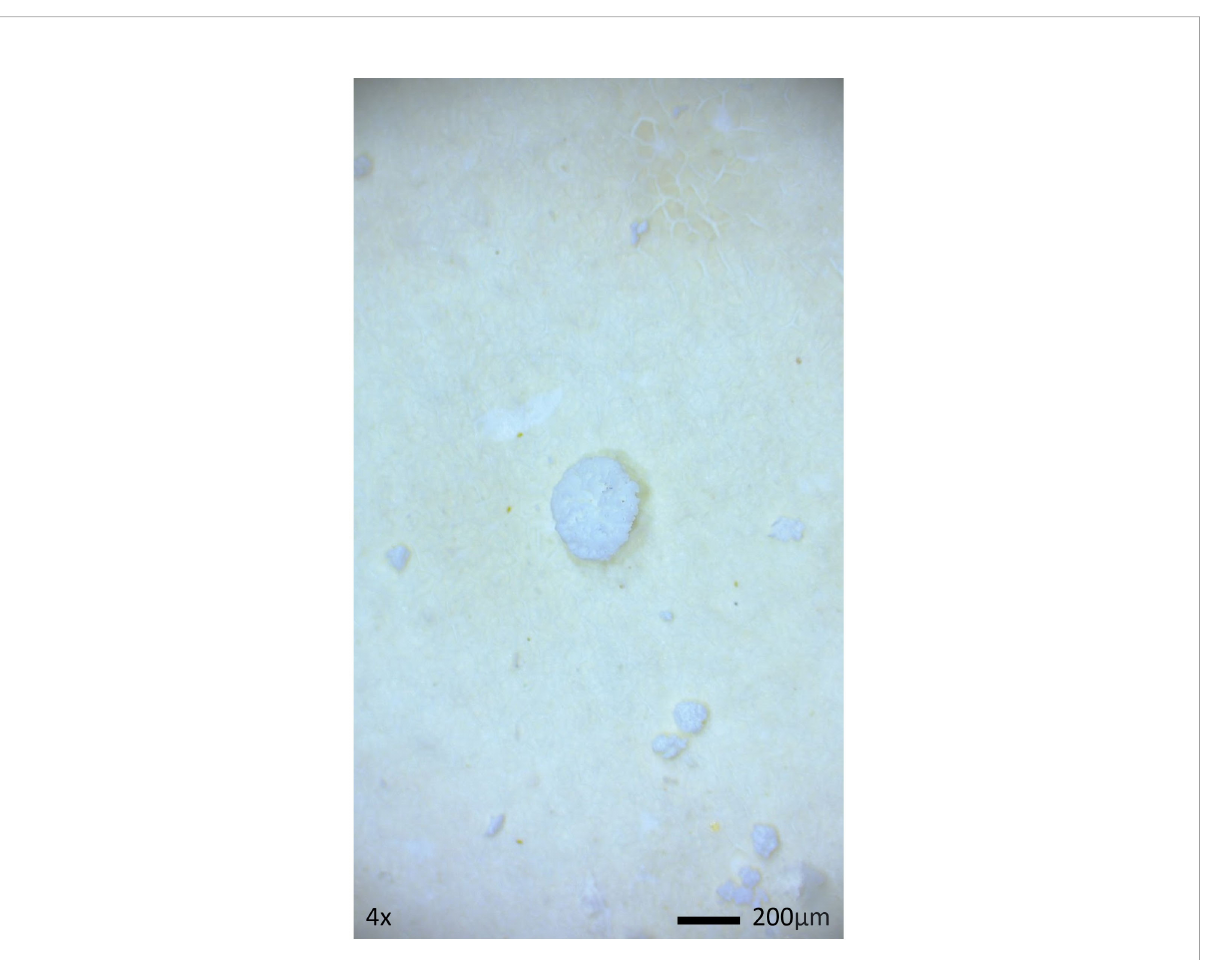
FIGURE 2 Example of White Foam from a Gastric Sample of a Bottlenose Dolphin Sampled in Sarasota Bay, Florida